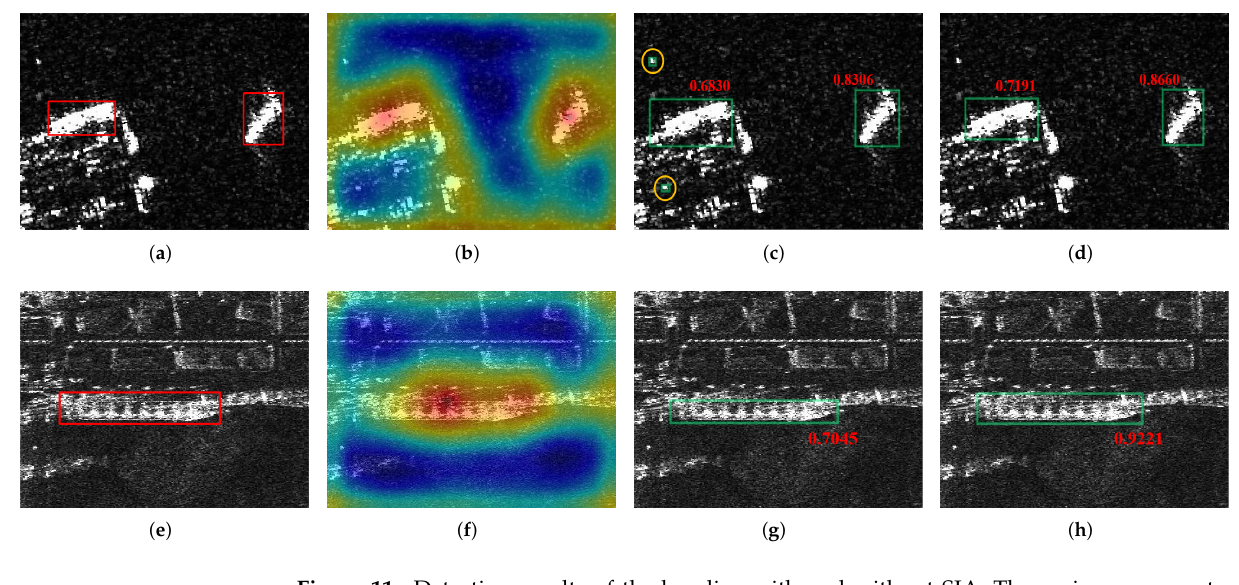
Figure 11. Detection results of the baseline with and without SIA. The spring-green rectangles represent the detection results, and the orange circles represent the false alarms. The red number reflects the IoU between the prediction result and the corresponding ground truth. ( a , e ) Ground truth. ( b , f ) Visualization of the confidence maps with SIA. ( c , g ) Detection results of the baseline. ( d , h ) Detection results of the baseline with SIA. Table 5. The comparison results with SENet, scSE, CBAM, CoAM, CoordAtt and our